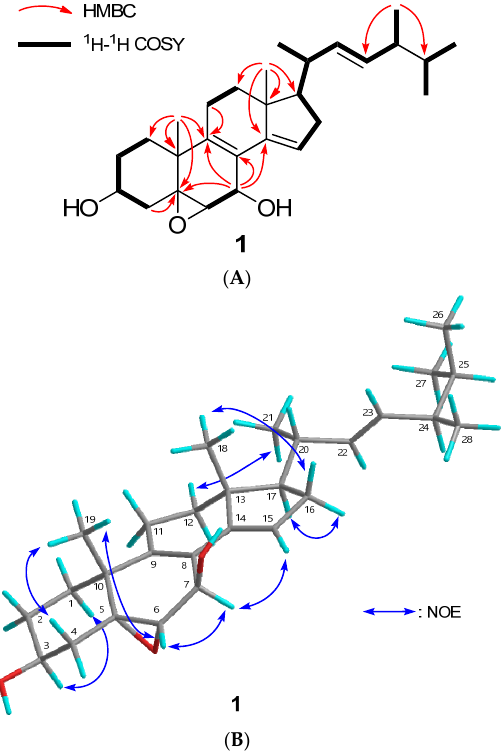
Figure 2. Structure determination of compound 1 . ( A ) Key HMBC and 1 H- 1 H COSY correlations of compound 1 ; ( B ) Key NOE correlations of compound 1. The atoms of C, H, and O were shown in grey, aqua, and red, respectively.